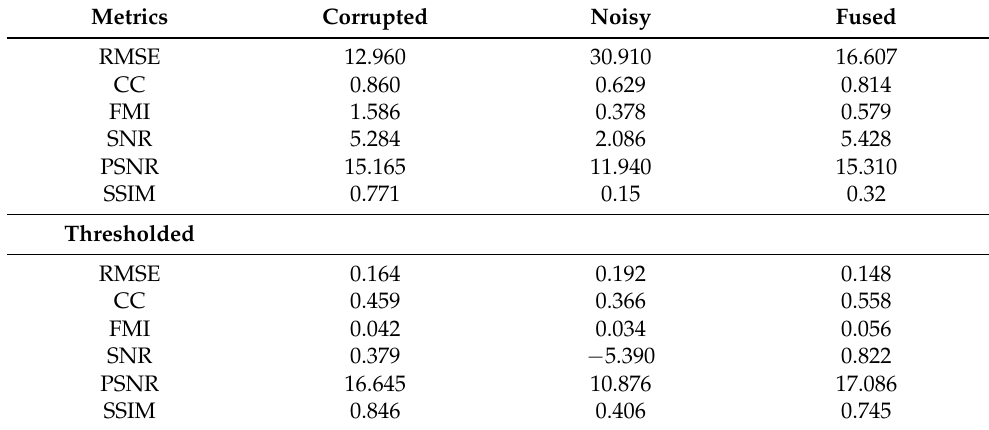
Table 9. A comparison of the evaluation metric values for the illustrative example for fusion metrics. Metrics Corrupted Noisy